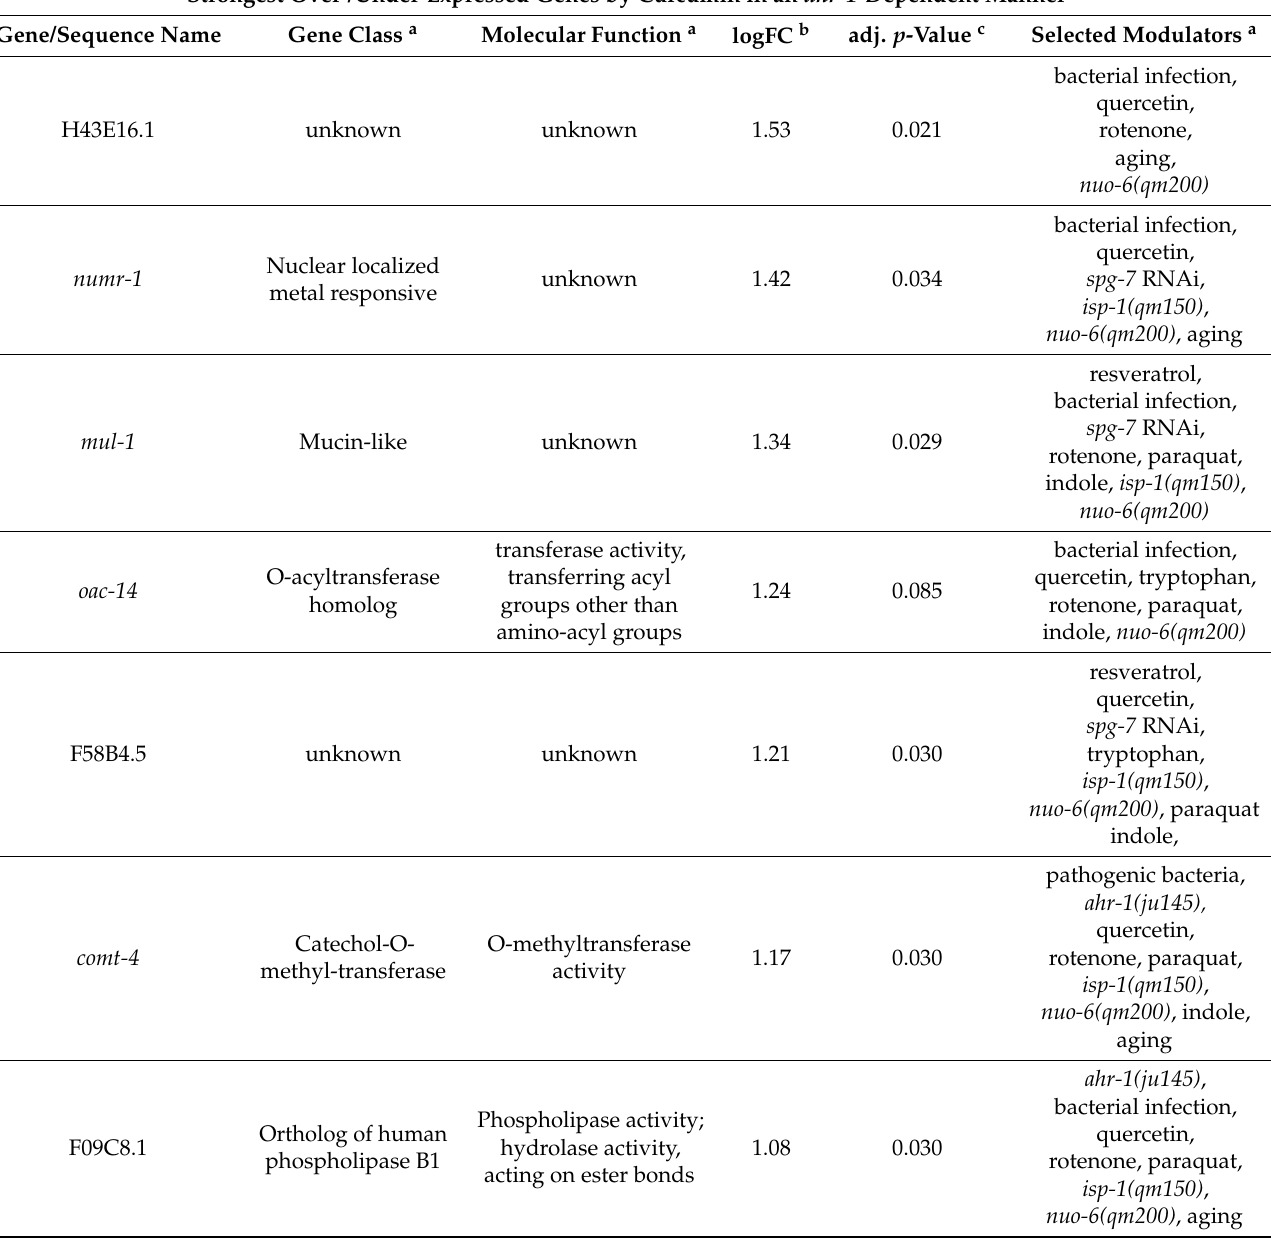
diagram of differentially expressed genes on the microarray. The number of genes that were differen- tially up- or down-regulated between the indicated conditions is shown in red and blue, respectively. The numbers in the interchanges refer to the genes that occurred in both comparisons. The values in the lower right corner show the number of genes on the array that were not differentially expressed. Table 1. List of genes from the microarray